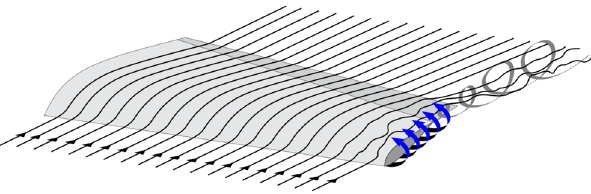
Figure 10. Pressure distribution on the wing surface disturbance by the flow field on the wingtip.